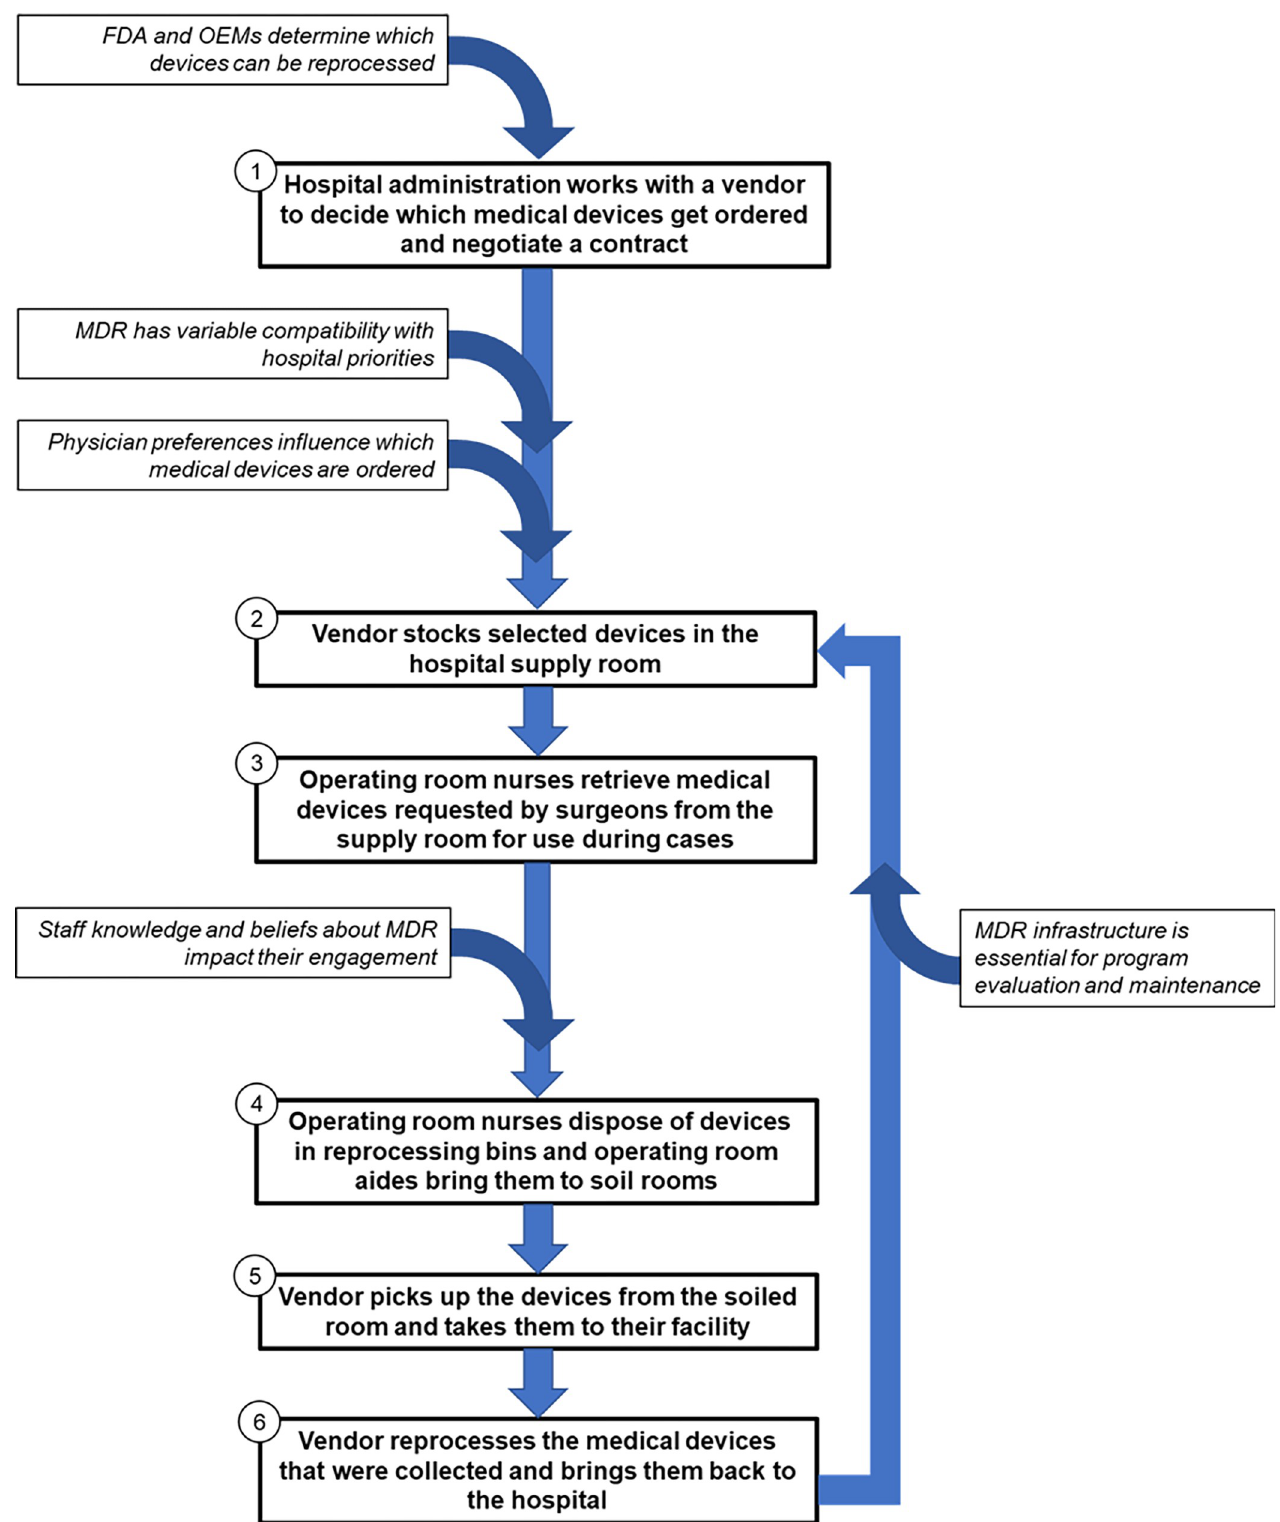
Fig 1. Conceptual model describing the six steps of implementing MDR and related themes. Abbreviations : MDR, medical device reprocessing; OEMs, original equipment manufacturers; FDA, Food and Drug Administration.